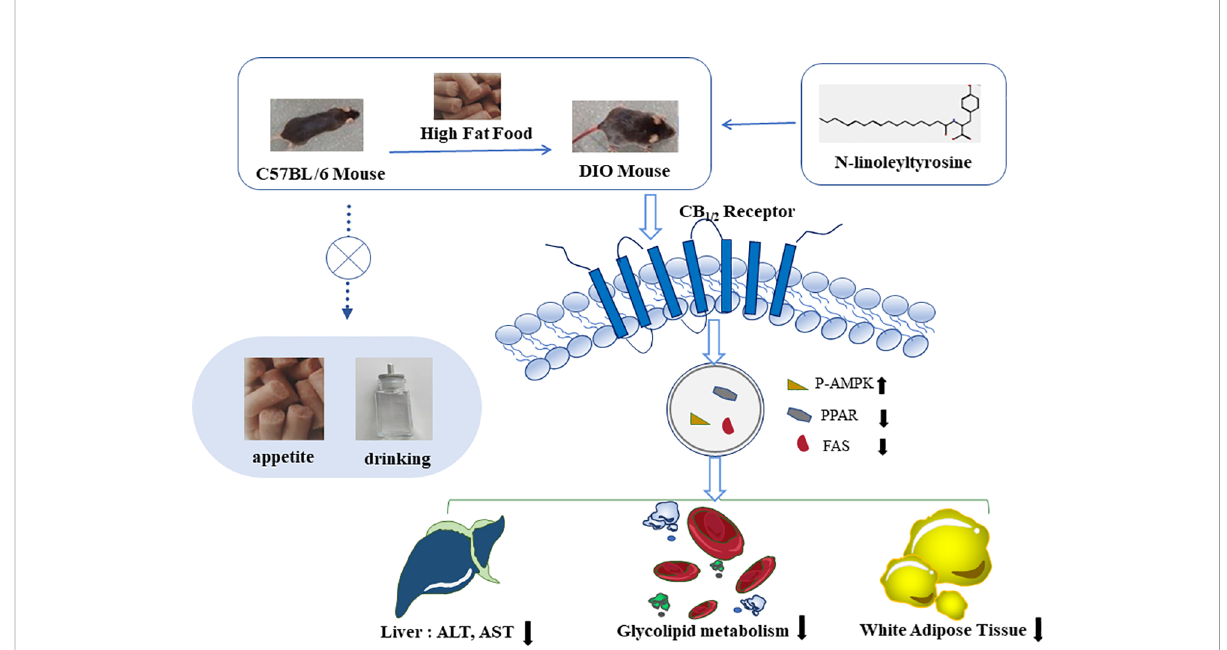
FIGURE 8 N-linoleyltyrosine ameliorates high-fat diet-induced obesity in C57BL/6 mice via cannabinoid receptor regulation, involving in regulating lipid and glucose metabolism, but not